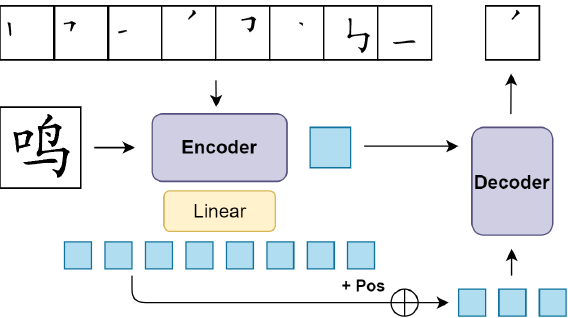
Figure 5. Our SAE architecture based on Resnet and Transformer. The encoder is applied on the images of Chinese characters and their image sequence of labels. The decoder FL reconstructs the stroke sequence images through the encoded patches of original image and stroke sequence images at the previous